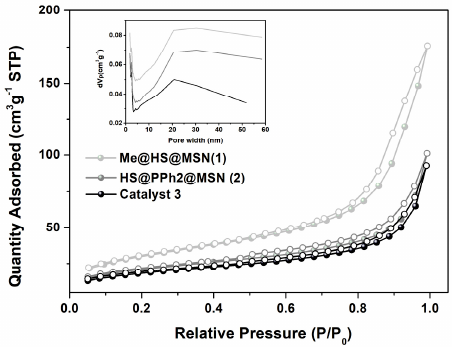
Figure 4. The nitrogen adsorption-desorption isotherms of one and catalyst 3 .